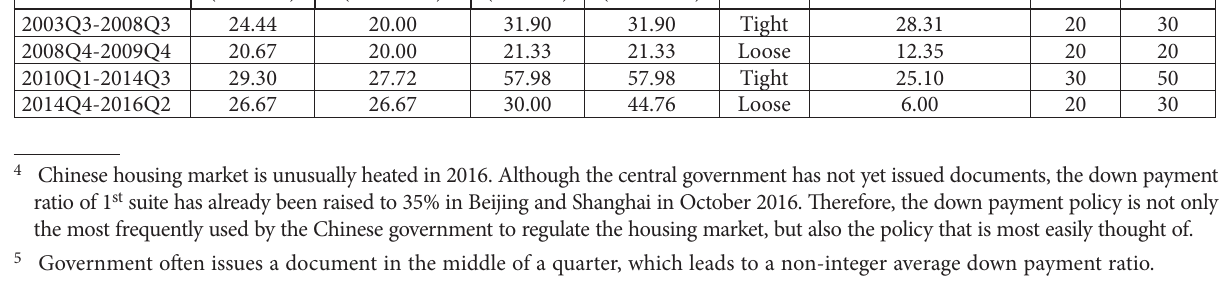
Table 2. Down payment ratio (national level, %) (data source: The People’s Bank of China and the State Council 5 ) Average down payment ratio Quarters